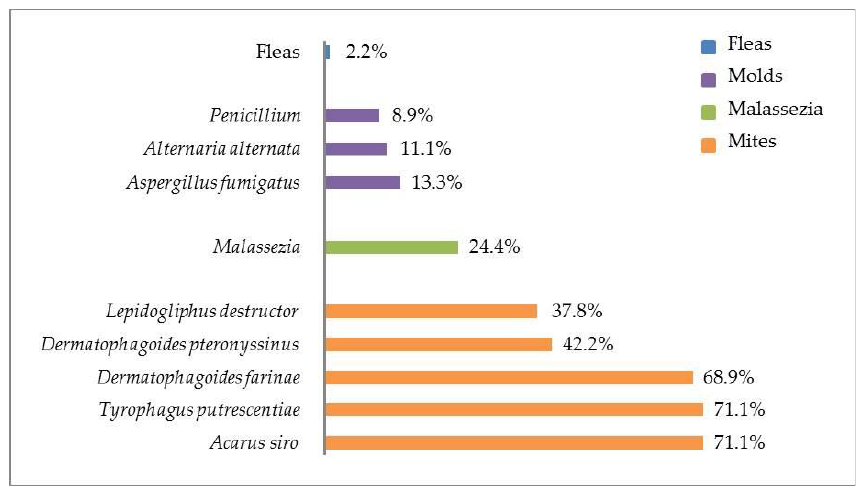
Figure 1. Distribution and percentage of various allergens in indoor allergen panel (fleas, molds, Malassezia, and mites) positive subjects ( n = 45) with canine atopic dermatitis. Frequent co-positives in the category of mites was found (Table 3). High co-positivity (>70%) was observed among Dermatophagoides farinae and Acarus siro ,